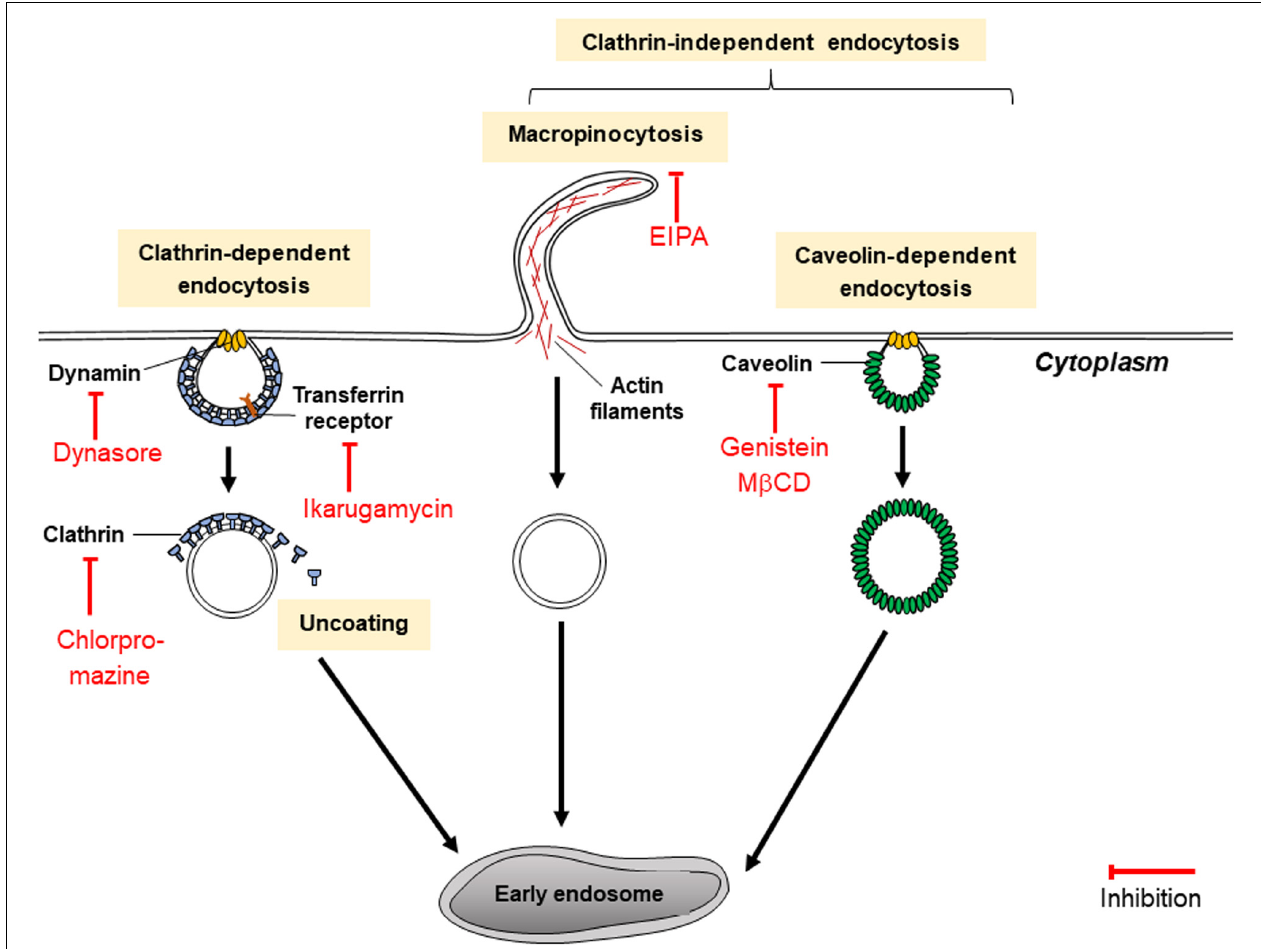
FIGURE 5 | Mechanisms of endocytosis inhibitors (dynasore, chlorpromazine, ikarugamycin, genistein, and M β